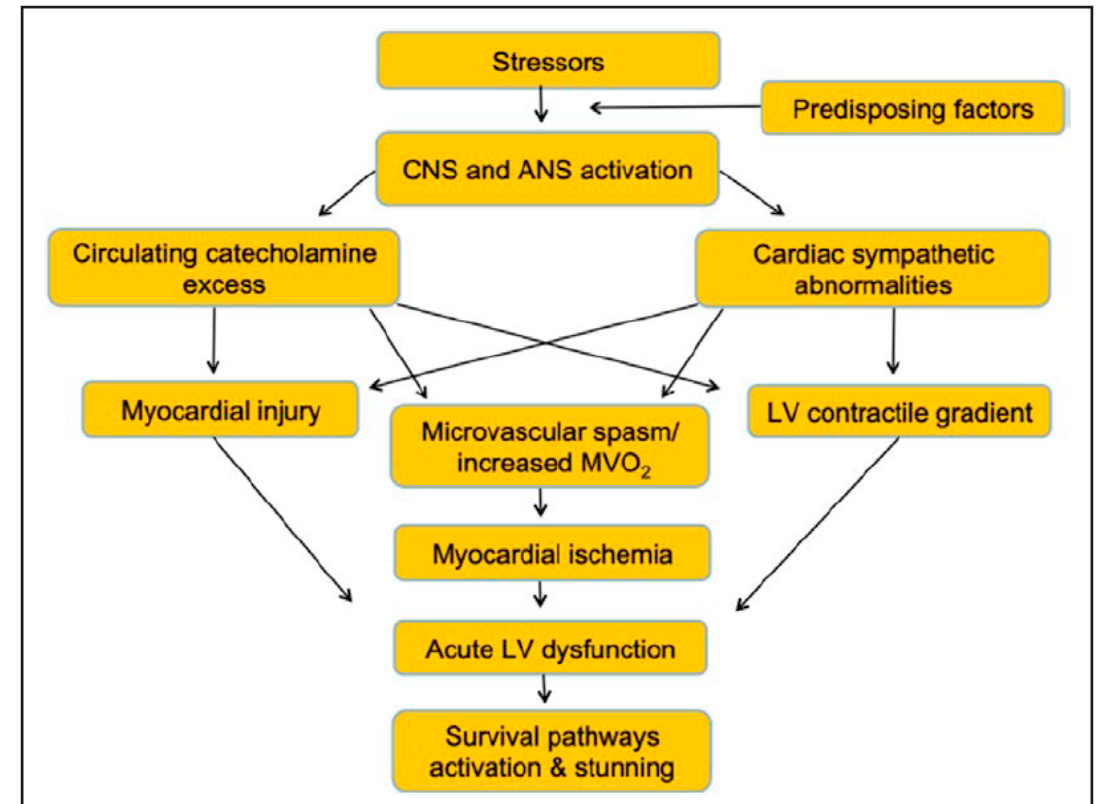
Figure 1. Key pathogenetic aspects in Takotsubo syndrome. The interplay between triggers, patho- genetic factors, mechanisms of cardiac injury, and clinical consequences. ANS indicates autonomic nervous system; CNS, central nervous system; LV, left ventricular; and MVo2, myocardial oxygen consumption. (Reprinted with permission from Aimo A et al. Int J Cardiol. 2021, 333, 45-50).